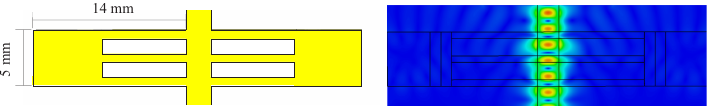
Figure 14. On the right, the simulation model of the mounting structure; on the left, the corresponding field